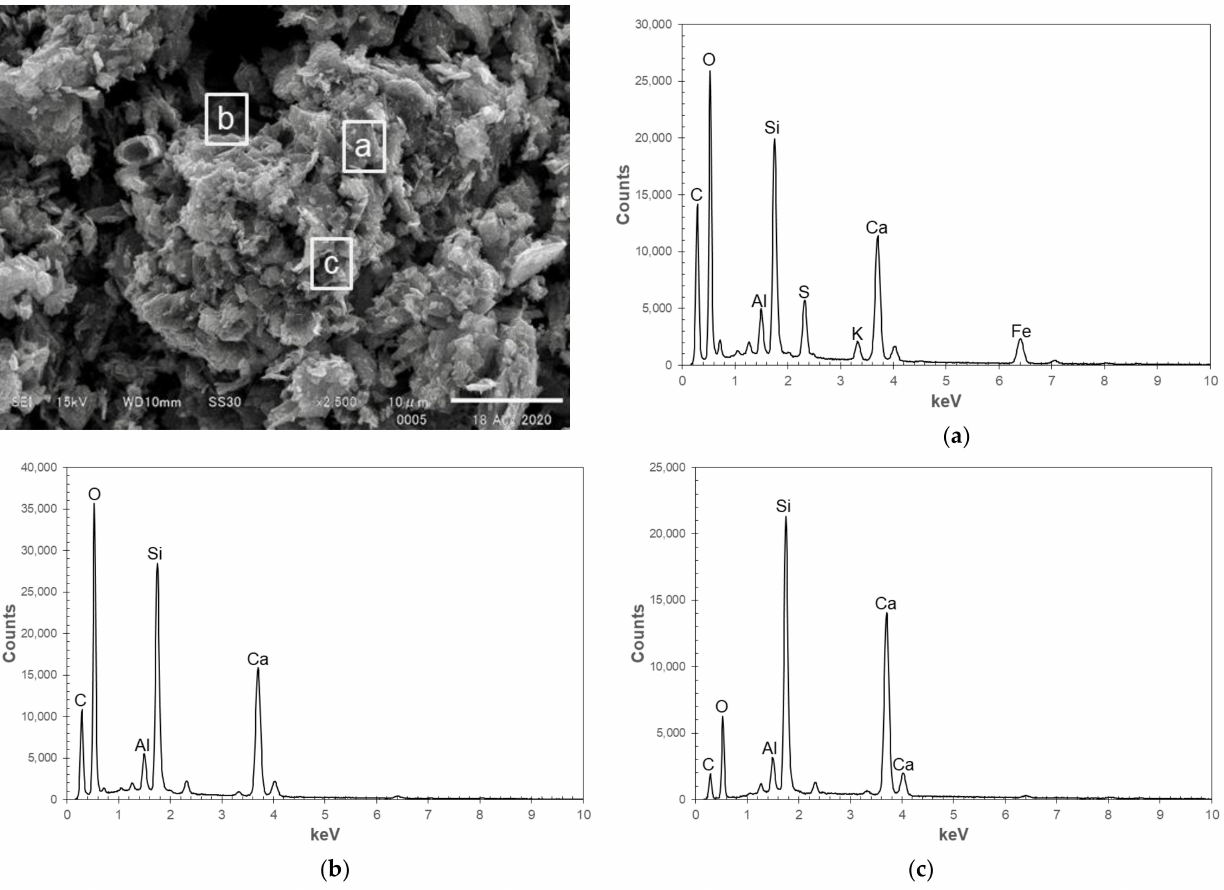
Figure 3. Secondary electron (SE) image and SEM-EDS analysis of reacted mudstone. Batch experiment 10:1 F:S with the ‘evolved’ OPC leachate. The white squares ( a – c ) in the SEM image indicate areas used for SEM-EDS analysis, and the corresponding figures ( a – c ) show the presence of primary minerals ( a ) and secondary C-S-H ( b , c